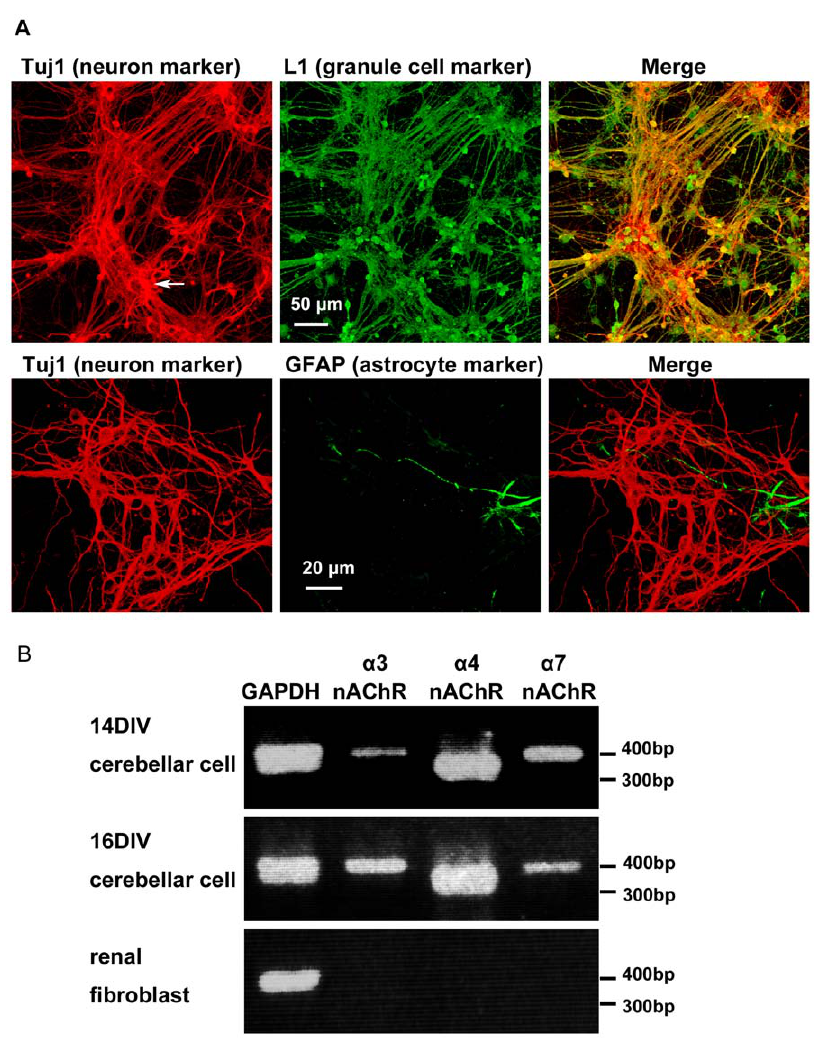
Figure 1. Cerebellar cell culture at 14 DIV and RT-PCR of nAChR subunits. ( A ) As can be seen in the upper panels, most of Tuj1-positive small neurons were immunoreactive for L1, which indicates that they are granule cells. The large Tuj1-positive neurons (arrow) are Purkinje cells, based on their shape and size. As can be seen in lower panels, the Tuj1-positive neurons and GFAP-positive astrocytes are clearly distinct. ( B ) RT-PCR of nAChR subunit transcripts in cerebellar cultured cells and renal fibroblast cultures. The mRNA transcripts for the a 3, a 4, and a 7 nAChR subunits were amplified from cerebellar cultures at 14 and 16 DIV and from renal fibroblasts. GAPDH was used as a positive control. Products of the predicted size were sequenced to confirm their identity. The a 3, a 4, and a 7 nAChR subunits were expressed in cerebellar cells but not in kidney